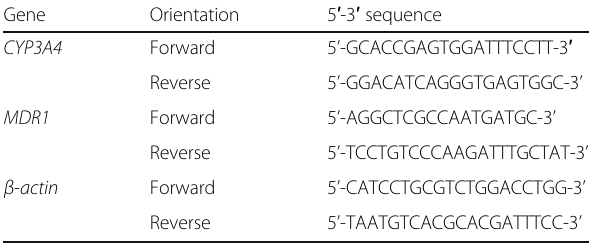
Table 1 Primer sequences used for real-time